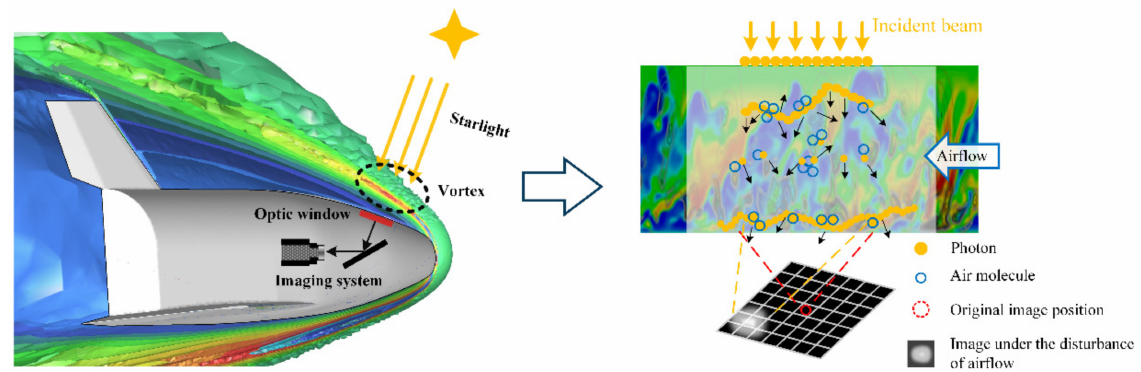
Figure 2. Microscopic process of photon transmission in turbulent molecules.